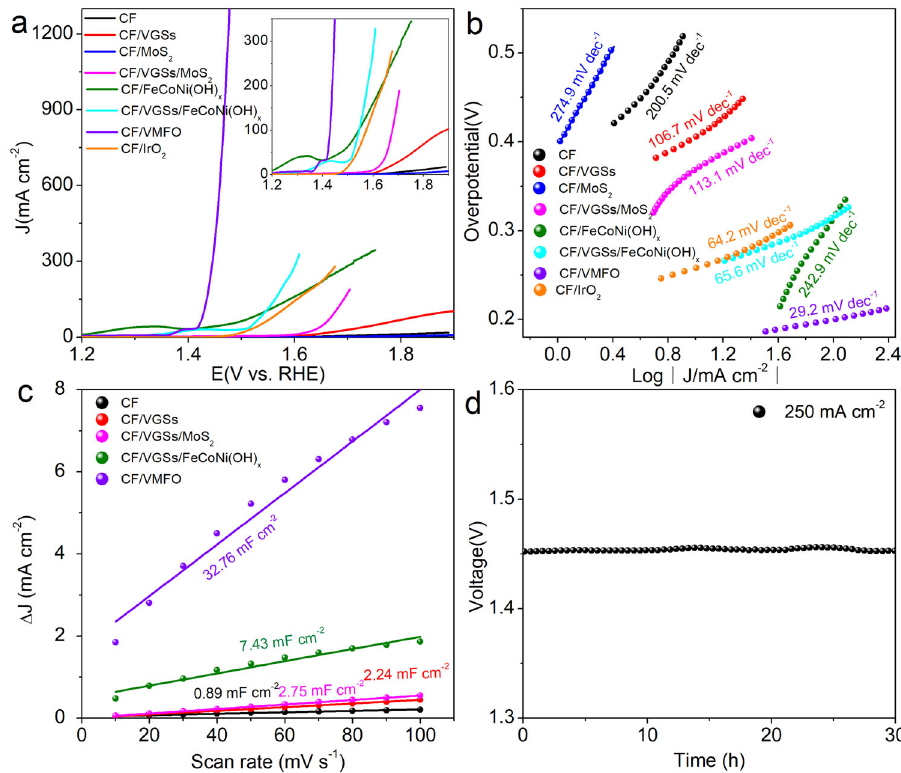
Fig. 5 OER performance of different samples tested in 1 M KOH. a LSV curves. b Tafel plots. c Capacitive currents at different scan rates. d Time- dependent overpotential curve of CF/VMFO at 250 and 500 mA cm − 2